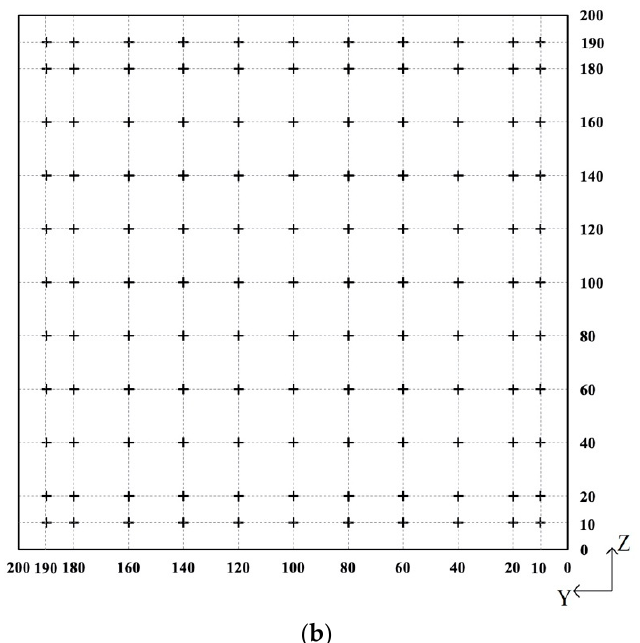
Figure 3. Measurement locations: ( a ) locations of measurement sections; ( b ) measurement locations arrangement in each section (all the dimensions are in centimeters).